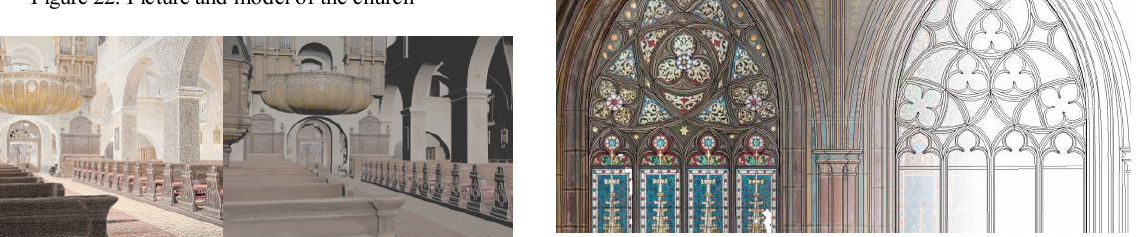
Figure 22. Picture and model of the church